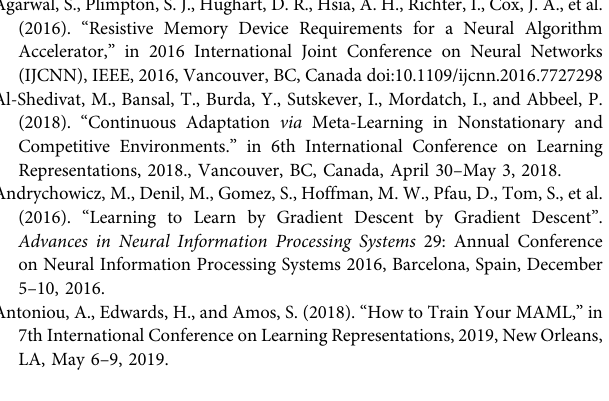
Frontiers in Arti fi cial Intelligence |